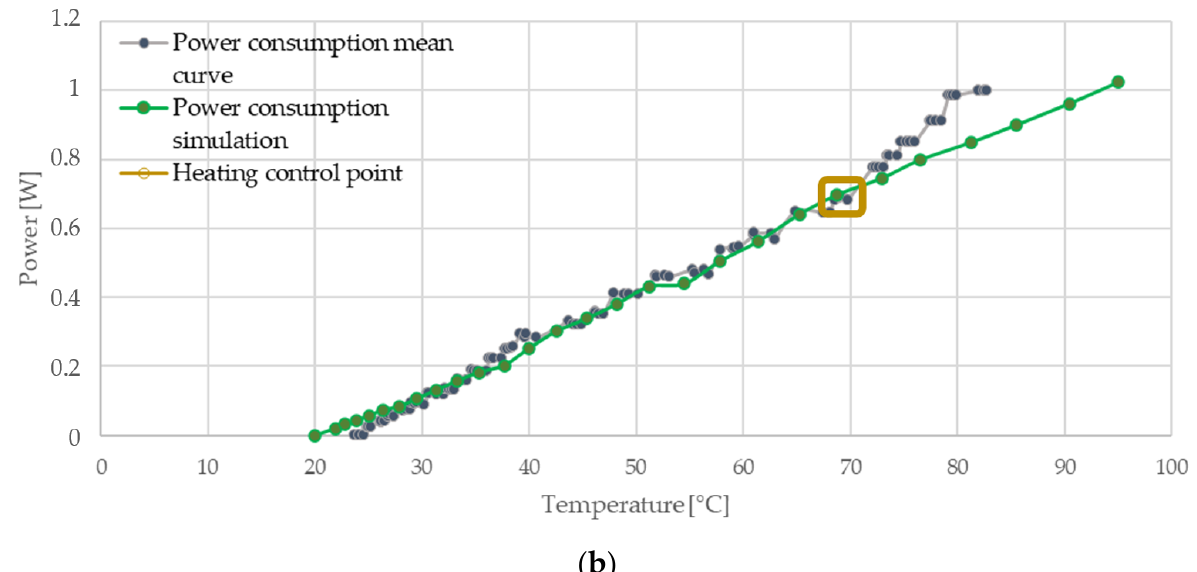
Figure 6. ( a ) Comparison system characterization between thermal camera mean curve and heating characterization curve behavior simulation based in 0.1 V step changes; ( b ) comparison between power consumption simulation based on resistance characterization curve and the mean measurement power consumption vs. temperature curve. Both comparisons have the heating control point highlighted.